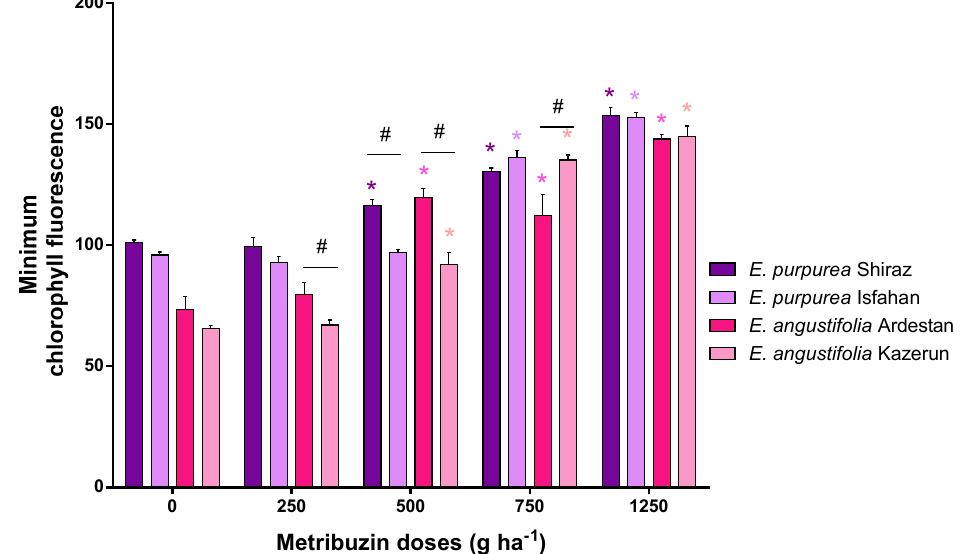
Figure 7. Effect of different metribuzin doses on minimum chlorophyll fluorescence of Echinacea purpurea and Echinacea angustifolia species. Data are shown as the mean ± SEM, and ordinary two-way ANOVA followed by Dunnett’s multiple comparisons test was used for statistical significance; * p < 0.005 vs. control (0 g ha − 1 metribuzin). Significant differences between Echinacea cultivars are indicated with #.